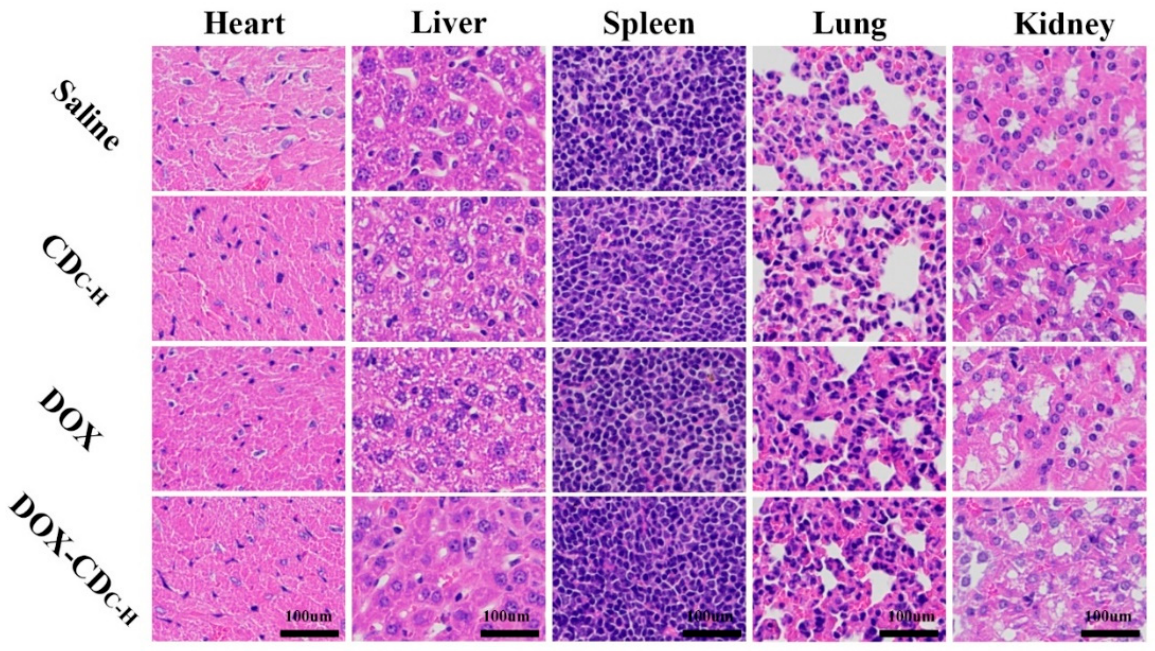
Figure 10. H&E staining of major organs of mice after different treatments (saline as control group, CD C-H , DOX and DOX–CD C-H as the experimental groups). Scale bars: 100 µm.